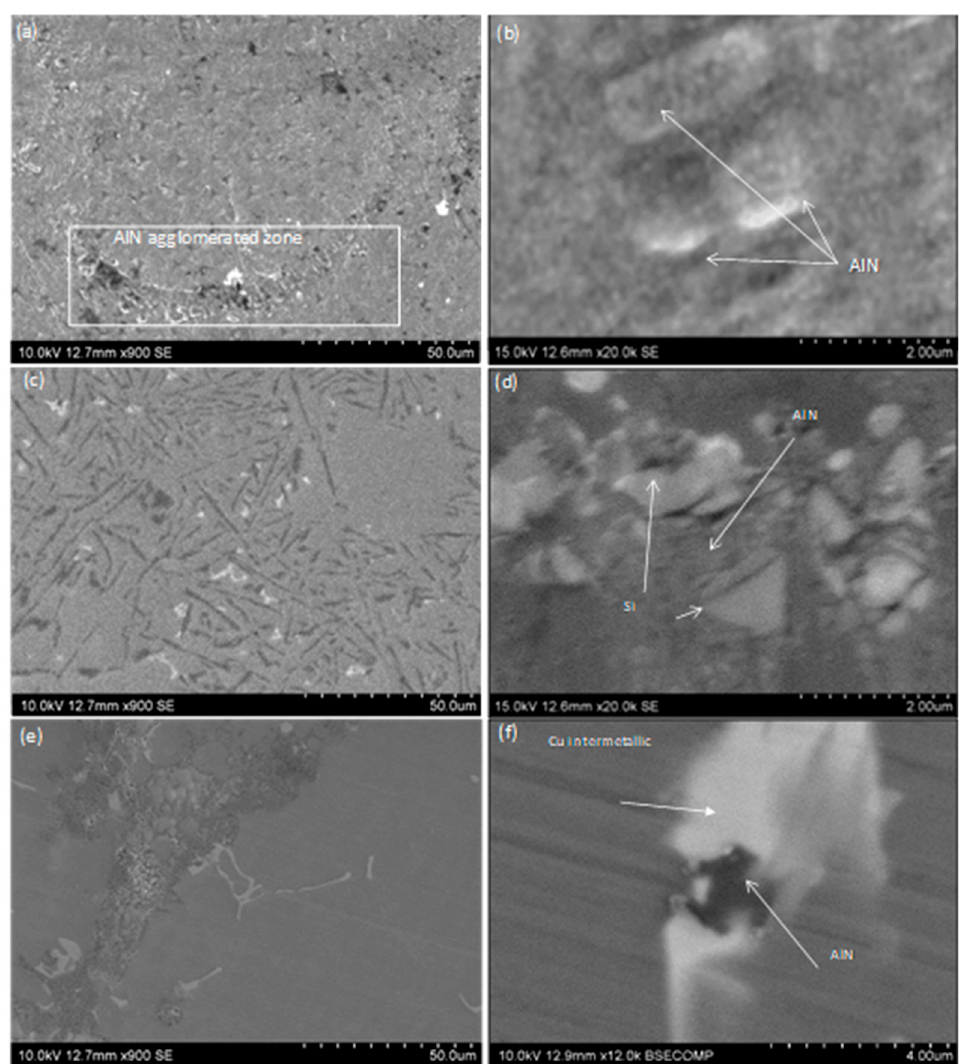
Figure 6. ( a ) Cross-section of Al/AlN coating on AA6082 aluminium alloy; ( b ) detail of the AlN particles on Al/AlN coating; ( c ) Al-12Si/AlN coating microstructure; ( d ) detail of the AlN particles on Al-12Si/AlN coating; ( e ) AA6061/AlN; ( f ) detail of the AlN particles on AA6061/AlN coating.